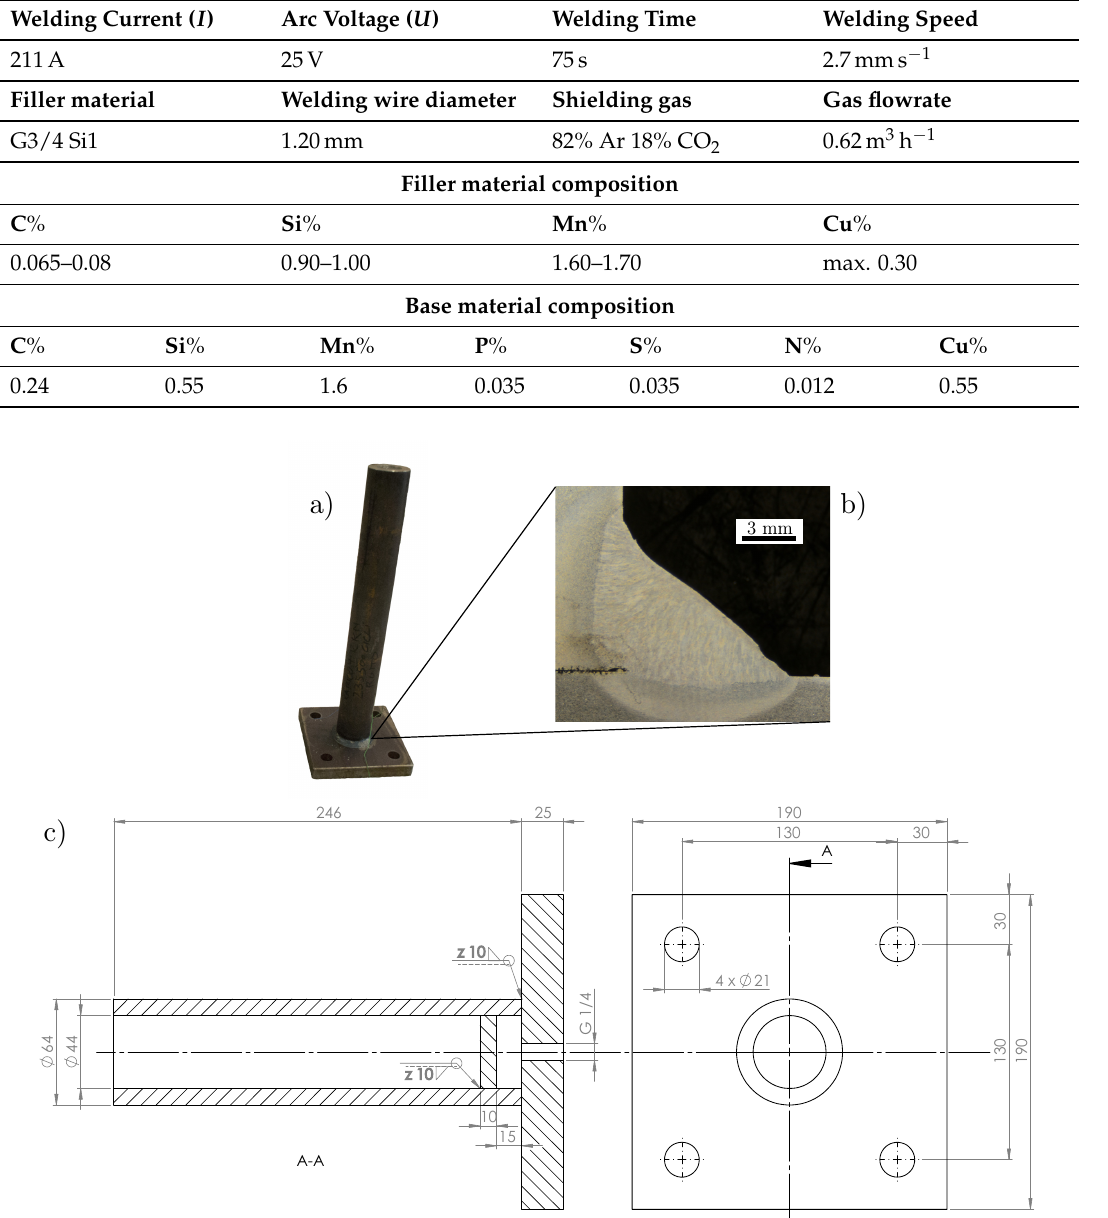
Table 1. Welding process parameters.